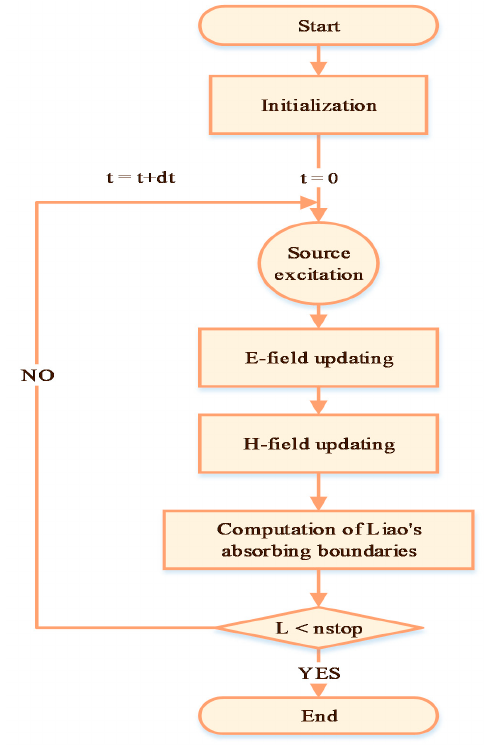
Figure 3. Finite difference time domain (FDTD) algorithm flowchart. Figure 3. Finite di ff erence time domain (FDTD) algorithm